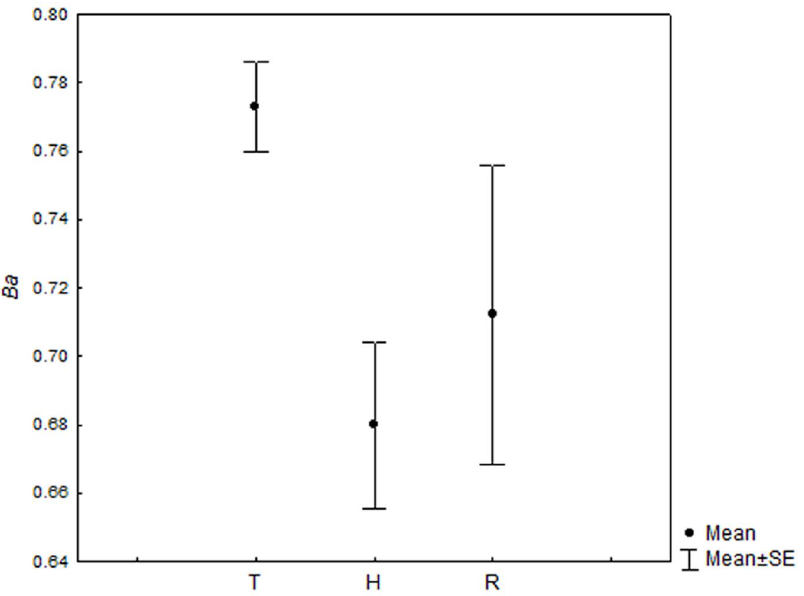
Figure 3. Values of trophic niche breadth for fish species analyzed in Alto Jacuı´ sub-basin. Values of trophic with mean 6 standart error for each specie analyzed in sampling units. For specie code see Table 1. doi:10.1371/journal.pone.0110999.g003 PLOS ONE |